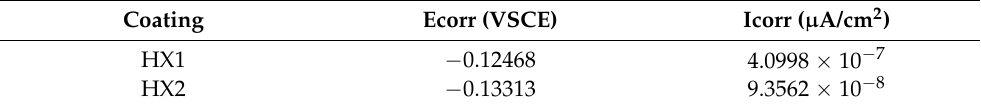
Table 4. Corrosion potential and corrosion current density of the coatings in a 3.5% NaCl solution.